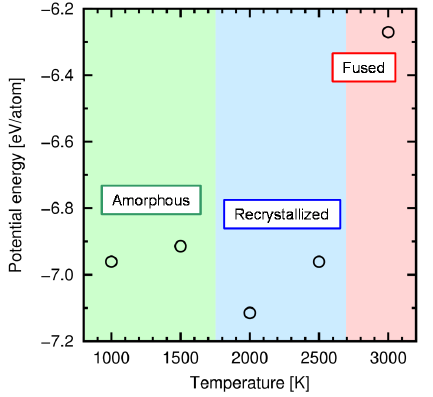
Figure 7. Potential energy of the quenched and relaxed structure at various temperatures (relaxa- tion for 500 ps). Three regions indicate the resultant atomic structure at each temperature.